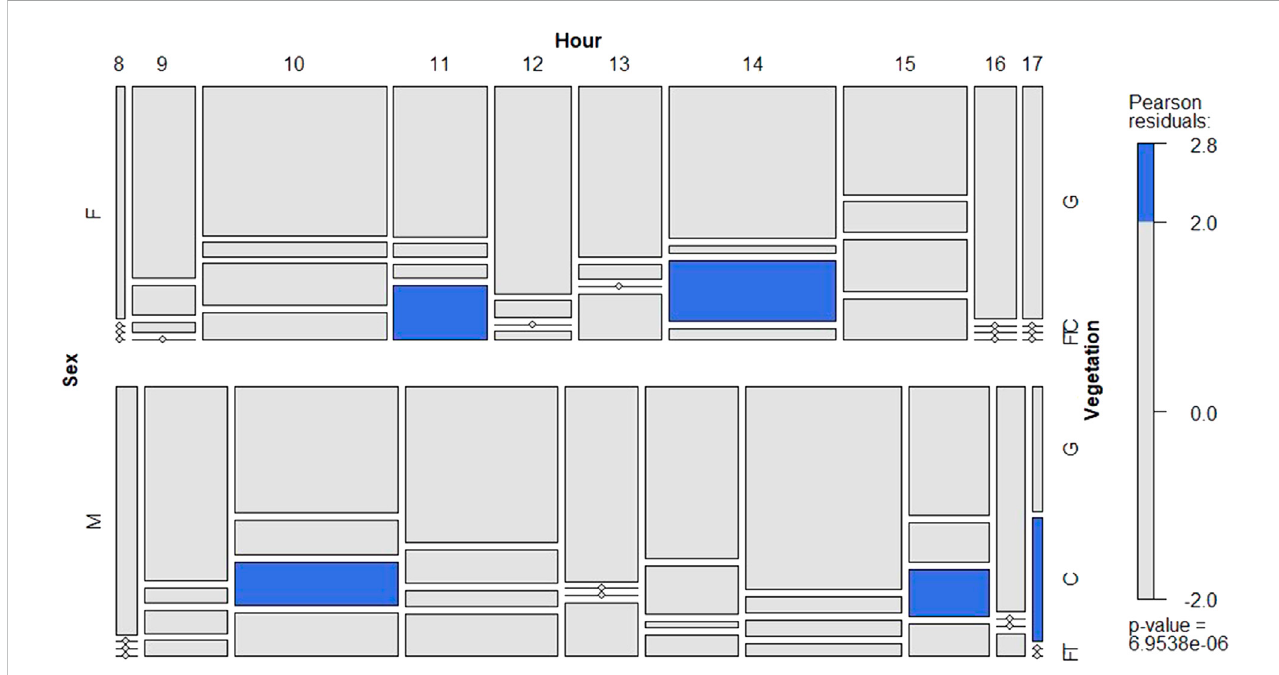
FIGURE 4 Conditional mosaic plot based on the contingency table with the number of locust records for female (left fi gure) and male (right) in daytime. For each development group it shows the departure from expectations per vegetation position (x-axis) and hour (y-axis). See details in Figure 2.